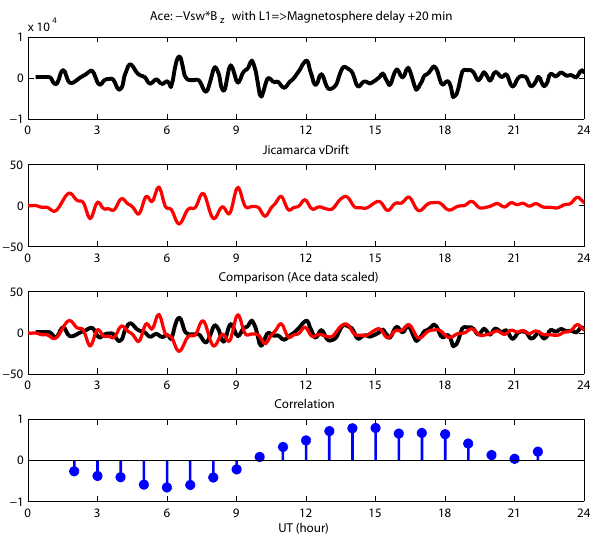
Fig. 4. Comparison of an electric field observed by the ACE satel- lite and the Jicamarca Observatory during 15 November 2003. No- tice an initial anti-correlation and then, later, a positive correlation between IEF y and the electric field observed at